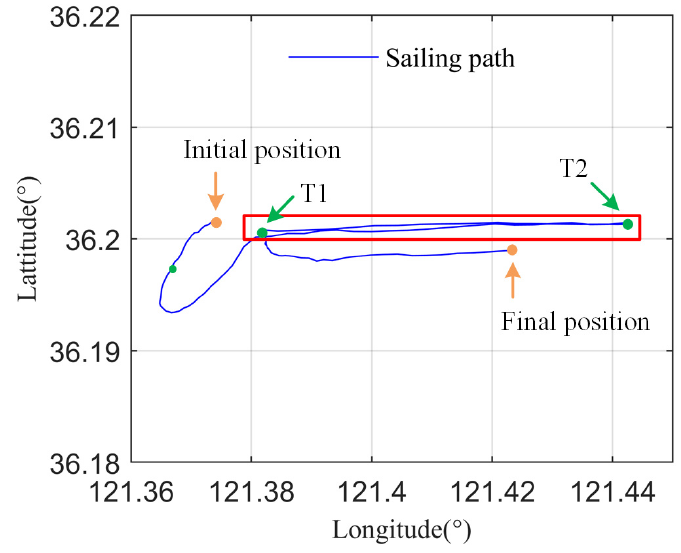
Figure 19. The trajectory of the wave glider.